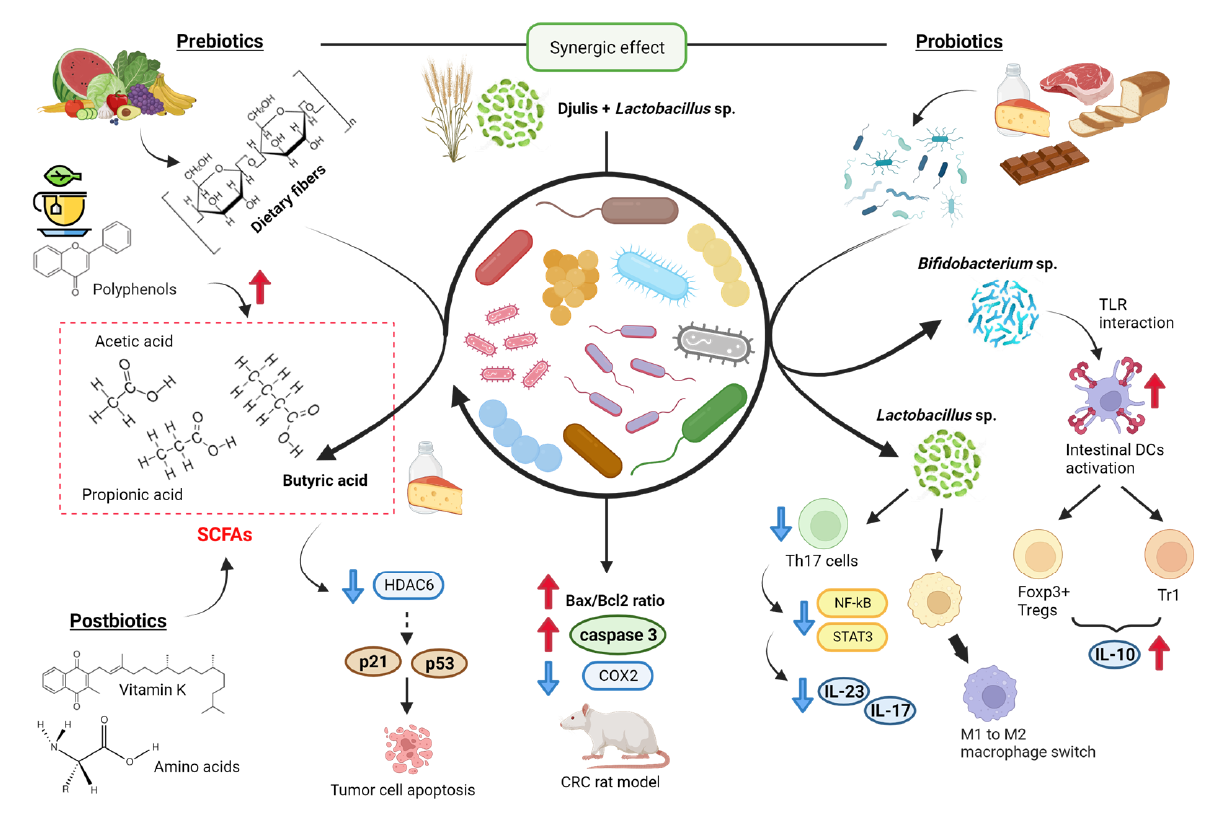
Figure 3. Prebiotics, probiotics, and postbiotics from the diet in CRC progression. Among pre- biotics, some polyphenols and dietary fibers induce SCFA production by “beneficial” bacterial genera [48,81,83,84]. Some probiotics regulate the expression of Dendritic cells, Th17 cells, and the M1-M2 switch [85]. Finally, the combination of prebiotics and probiotics reduces levels of inflammatory-related COX2 in a model [86]. Created with BioRender.com (accessed on 14 April 2023). Probiotics synergizing with prebiotics have a therapeutic impact on CRC [87]. Probi- otics are live microorganisms that have beneficial effects on the health of the host. Widely used probiotics are yeast strains of Saccharomyces cerevisiae and bacterial species of Lacto- bacillus, Bifidobacterium, Streptococcus, Lactococcus, and Escherichia coli [81]. Food-based probiotic products include dairy products (e.g., cheese, yogurts, ice cream, milk, acidi- fied milk and creams), meats and meat products, bread or other fiber snacks, chocolate, fruit juice, and other fruit preparations [88]. For example, yogurts contain bacteria from Bifidobacterium sp., Lactobacillus sp., and Streptococcus sp., and kefir includes Bifidobac- terium sp., Lactobacillus sp., Leuconostoc sp., and Saccharomyces sp. [89]. A study showed that a probiotic mixture treatment (consisting of Lactobacillus and Bifidobacterium species, resistant dextrin, isomalto-oligosaccharides, fructose oligosaccharides, and stachyose) de- creased the proliferation, migration, and invasion of CT26 colon cancer cell line in vitro as well as in BALB/c mice in vivo approach [90]. Specific probiotic strains of Bifidobacterium infantis and Bifidobacterium breve activate intestinal DCs through toll-like receptors (TLRs) and induce retinoid acid metabolism, driving the expression of Foxp3+ Tregs and type-1 regulatory T cells (Tr1) and IL-10 release [85]. Some other probiotic bacteria, such as Lac- tobacillus rhamnosus GG and Lactobacillus acidophilus, downregulate the expression of Th17 cells and secretion of IL23 and IL17 via inhibition of STAT3 and NF- κ B signaling or induce switch of macrophage phenotype from pro-inflammatory M1 to immunosuppres- sive M2. In fact, a clinical trial demonstrated that a probiotic administration (Lactobacillus, Bifidobacterium, and Streptococcus species) causes a statistically significant reduction in postoperative complications in the location of tumors in the rectum ( − 33.3%) and